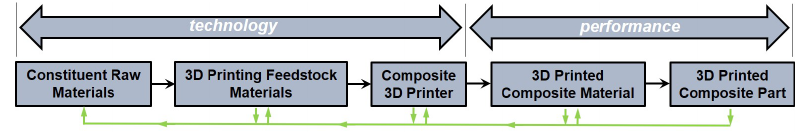
Figure 1. The systematic research and development approach.